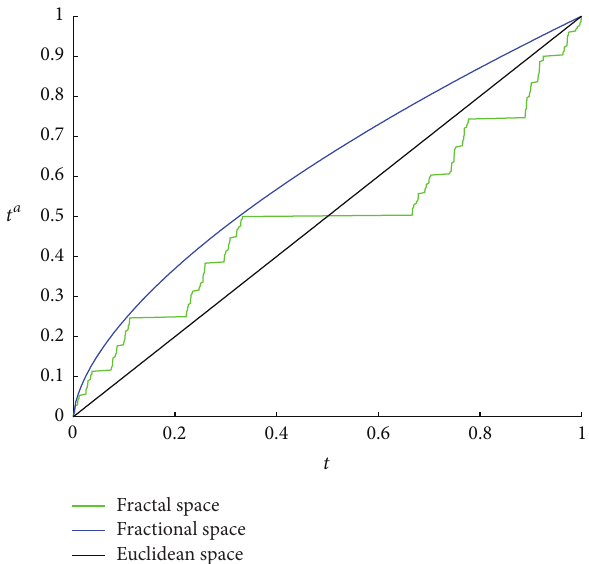
Figure 1: Graph for comparison of the measuring structures of time in fractal, fractional, and classical electrodynamics. with the elements of line Δ l